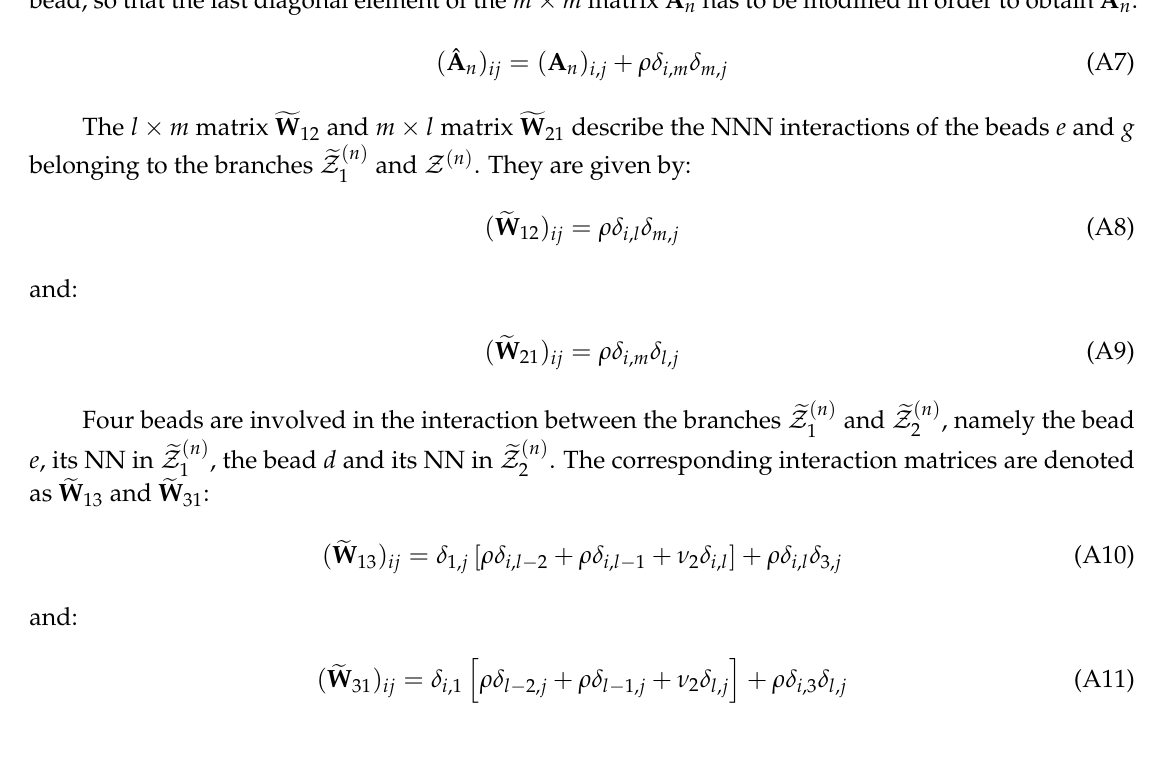
( n + 1 ) branch ( n + 1 ) Z Z e (cid:101)